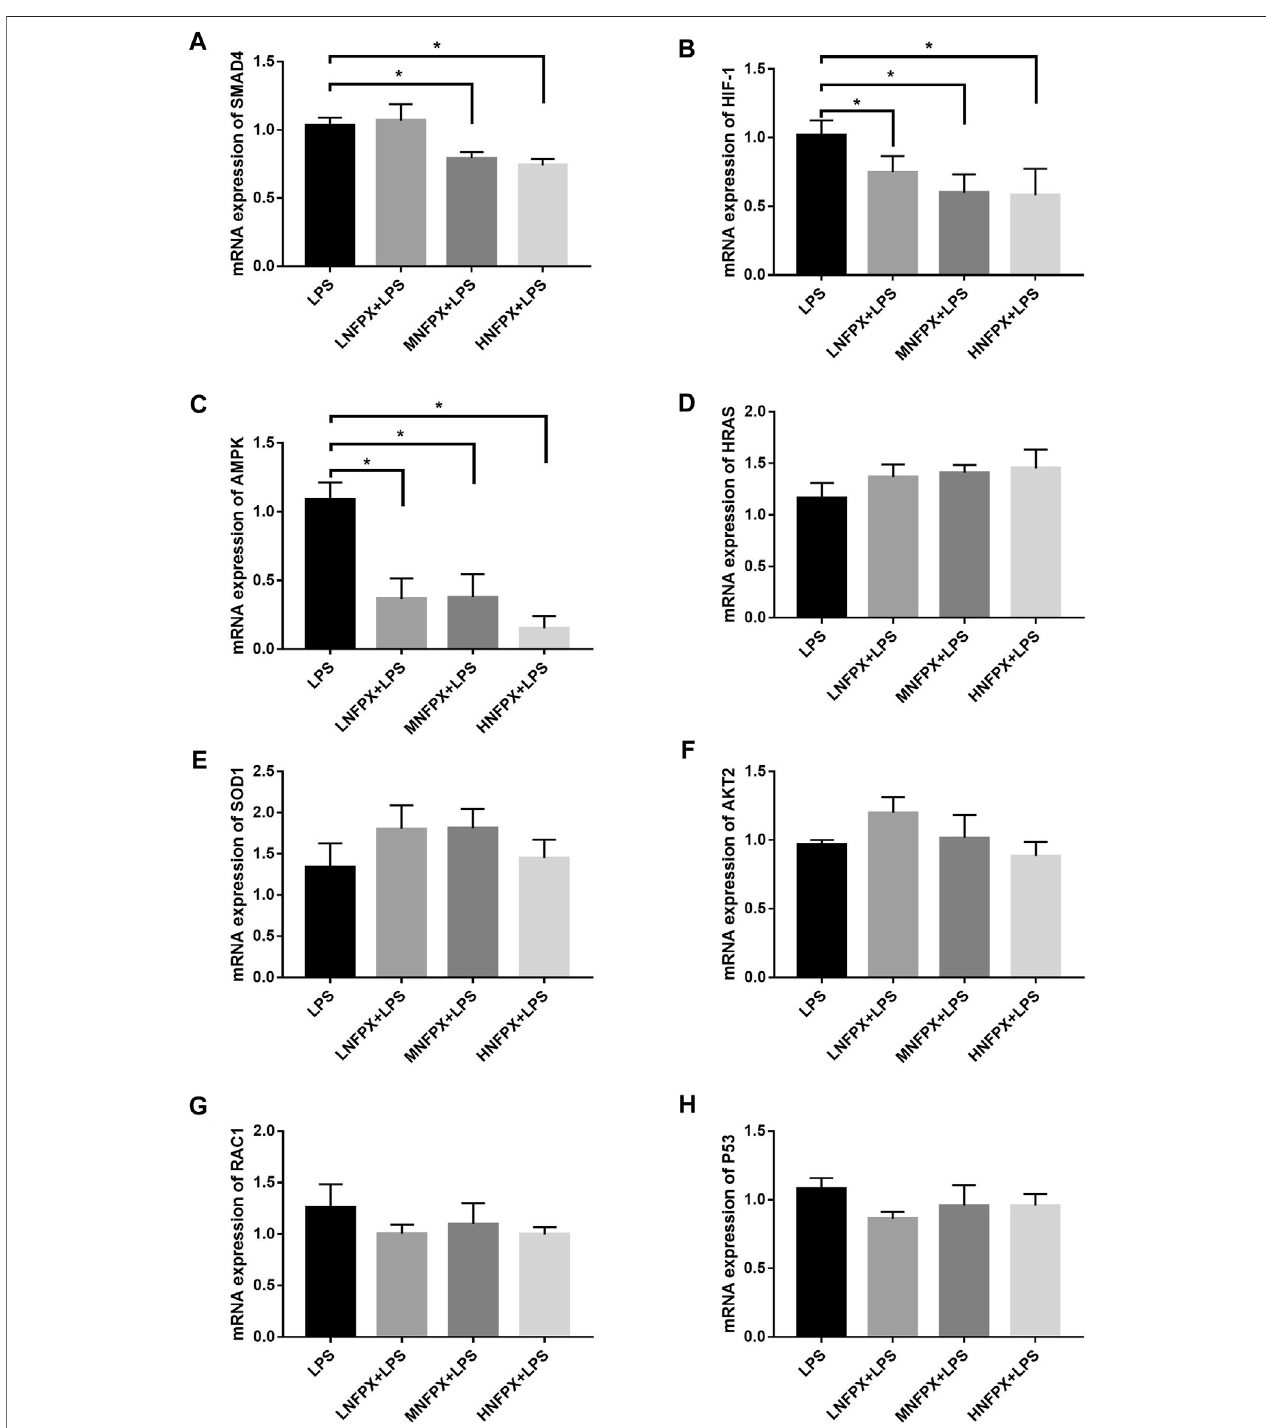
FIGURE 13 | mRNA expression of potential targets of NFPX by qRT-PCR. * p < 0.05.